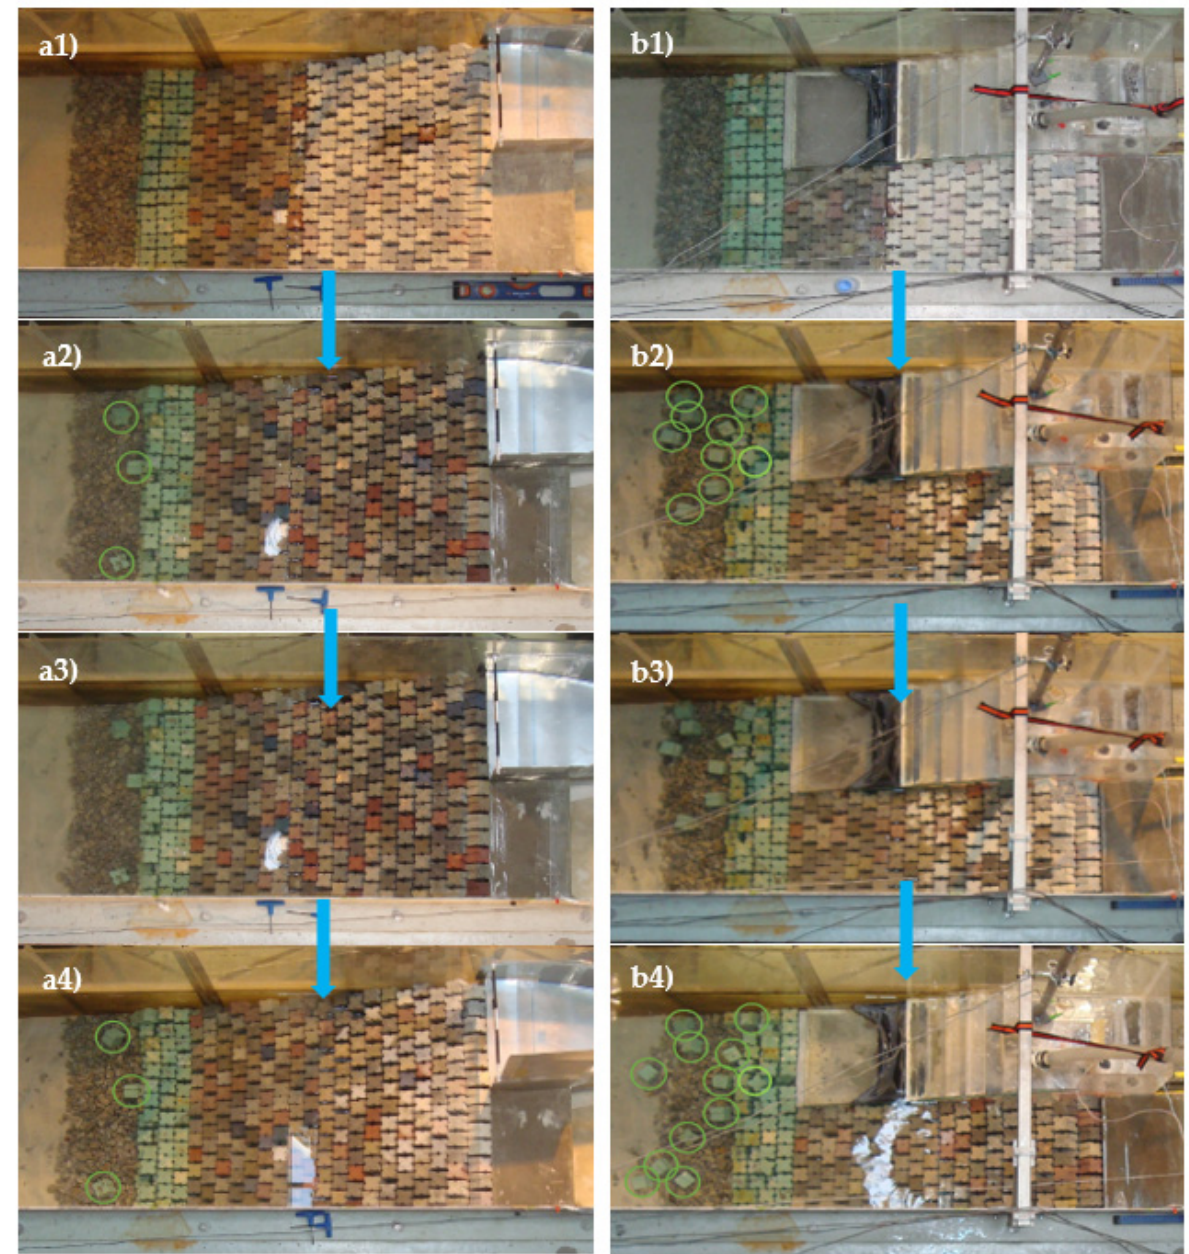
Figure 10. Evolution of the toe berm blocks and outer armour layer blocks, with ( a1 – a4 ) and without ( b1 – b4 ) the WEC: for MLWS, from initial disposition, (1), to final test, (2); for MHWS, from final test of MLWS, (3), to final test of the series, (4).